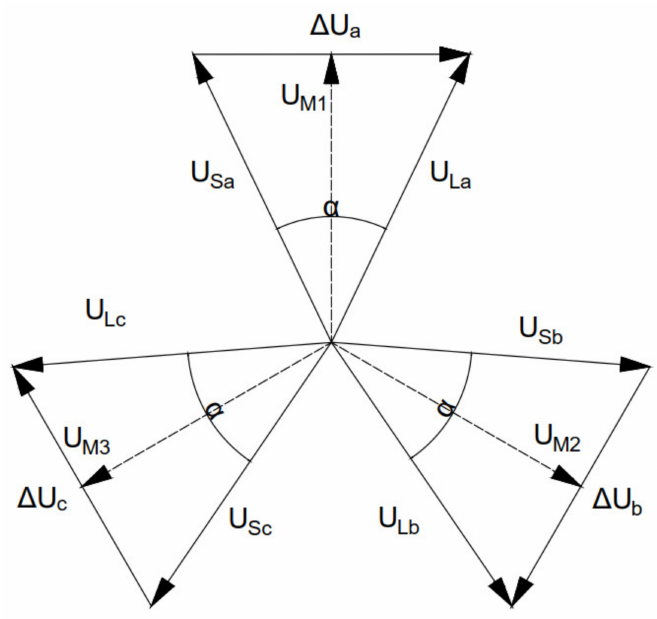
Figure 3. Phasor diagram for the symmetrical direct PST.